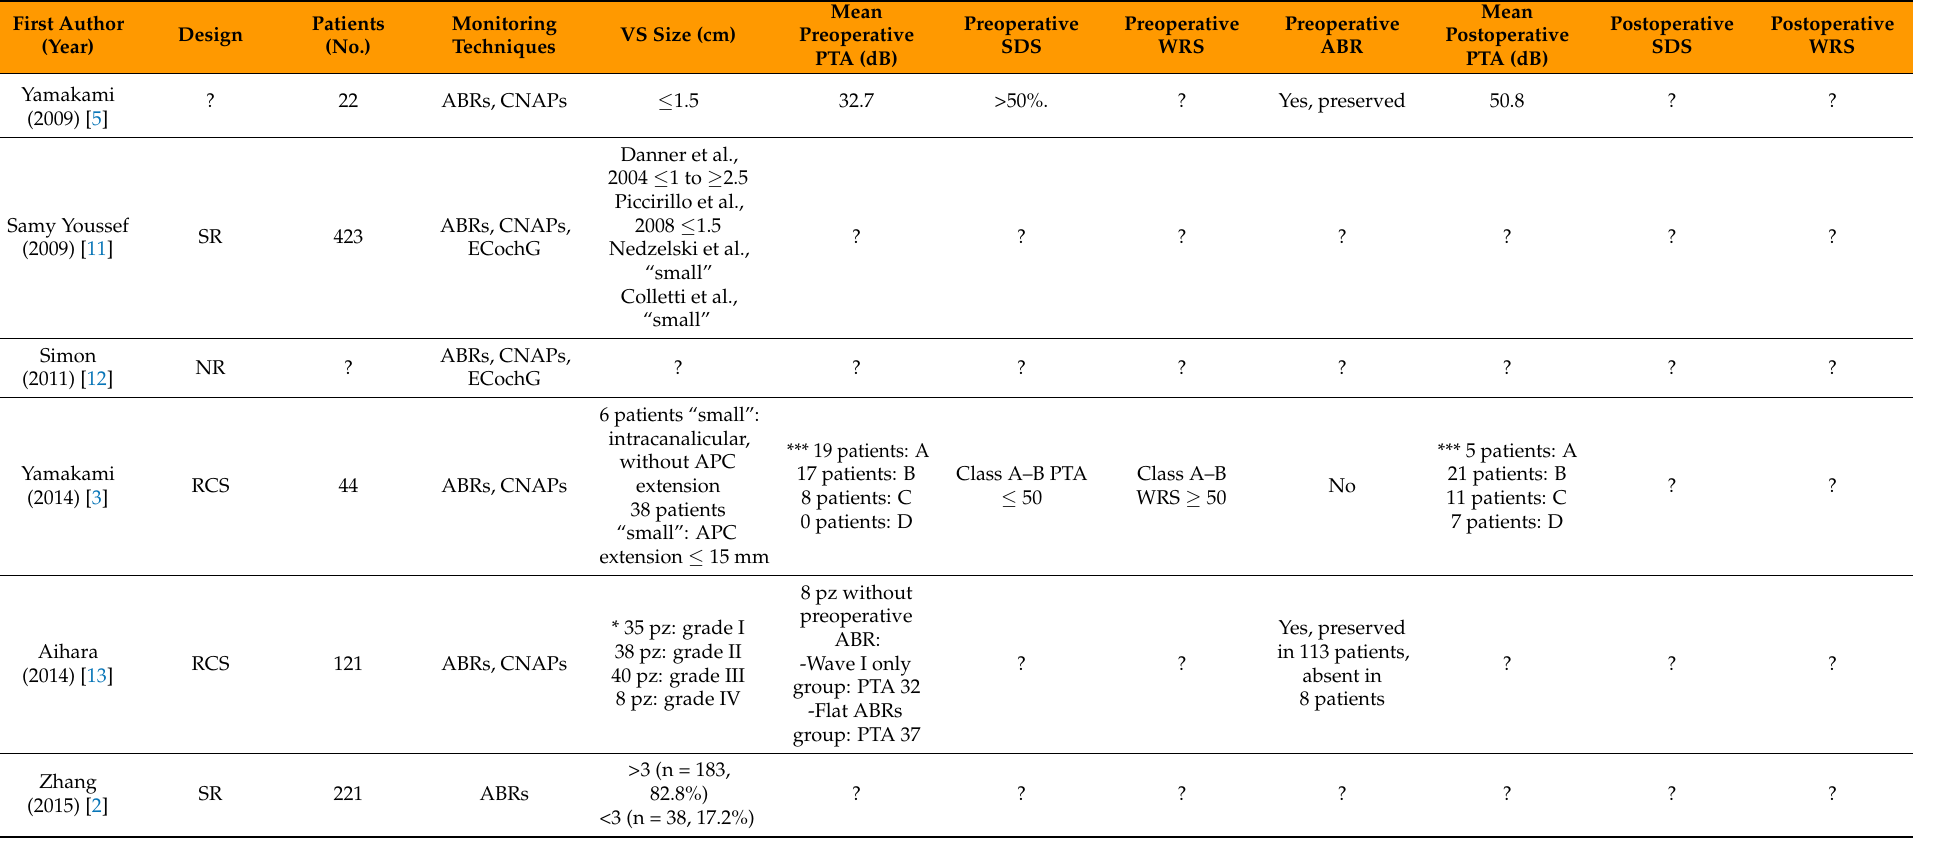
Table 1. Characteristics of the included studies in terms of efficacy of the monitoring techniques based on preoperative and postoperative